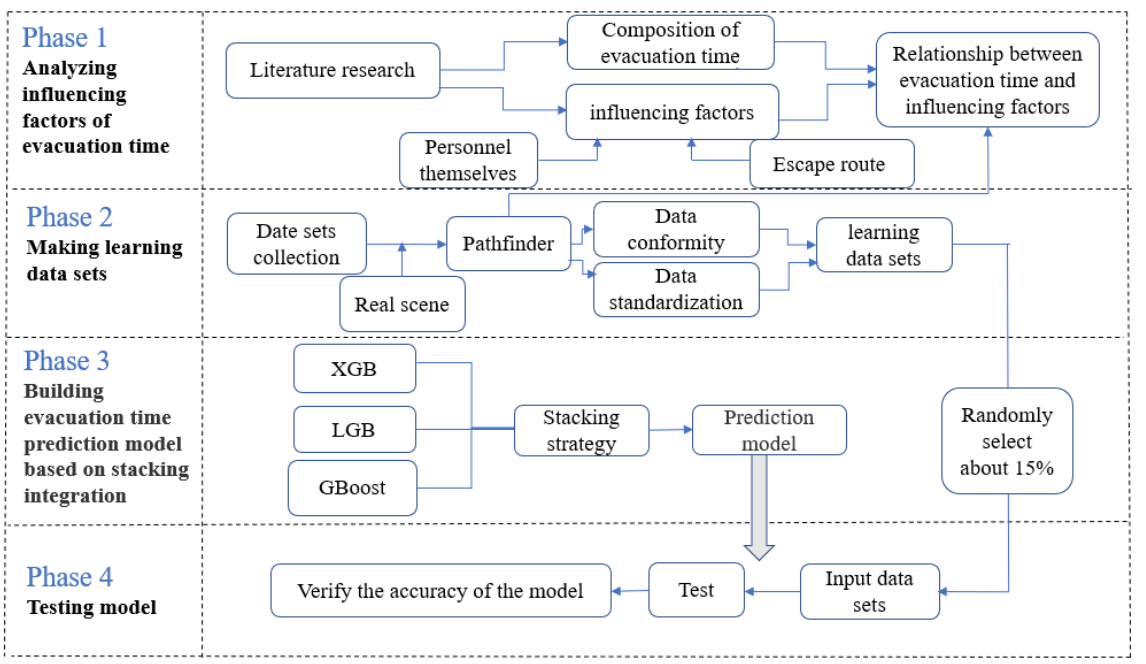
Figure 2. Development flow chart of evacuation time prediction model.